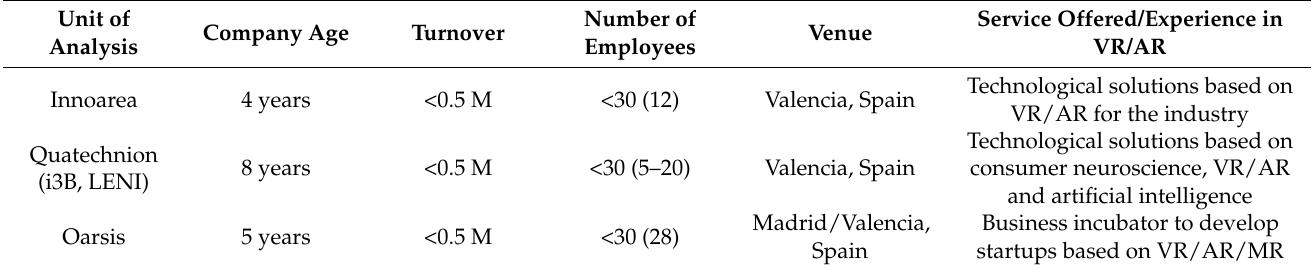
Table 1. Research units general